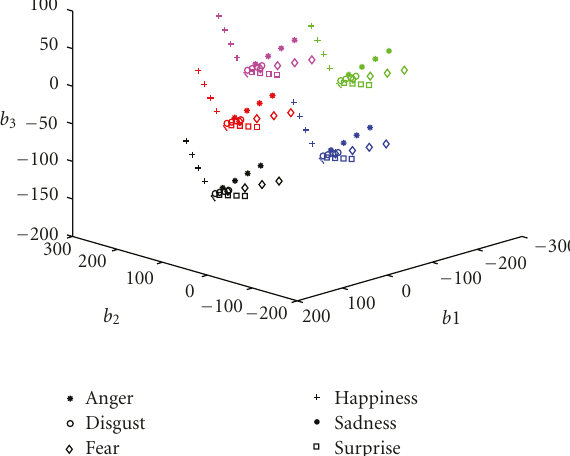
Figure 6: Visualization of the synthetic faces separability for six expressions and five subjects.